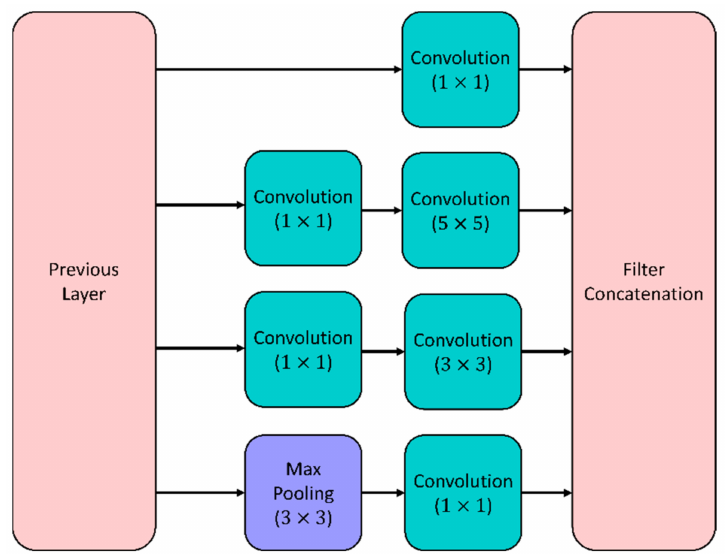
Figure 2. Inception module for the GoogleNet